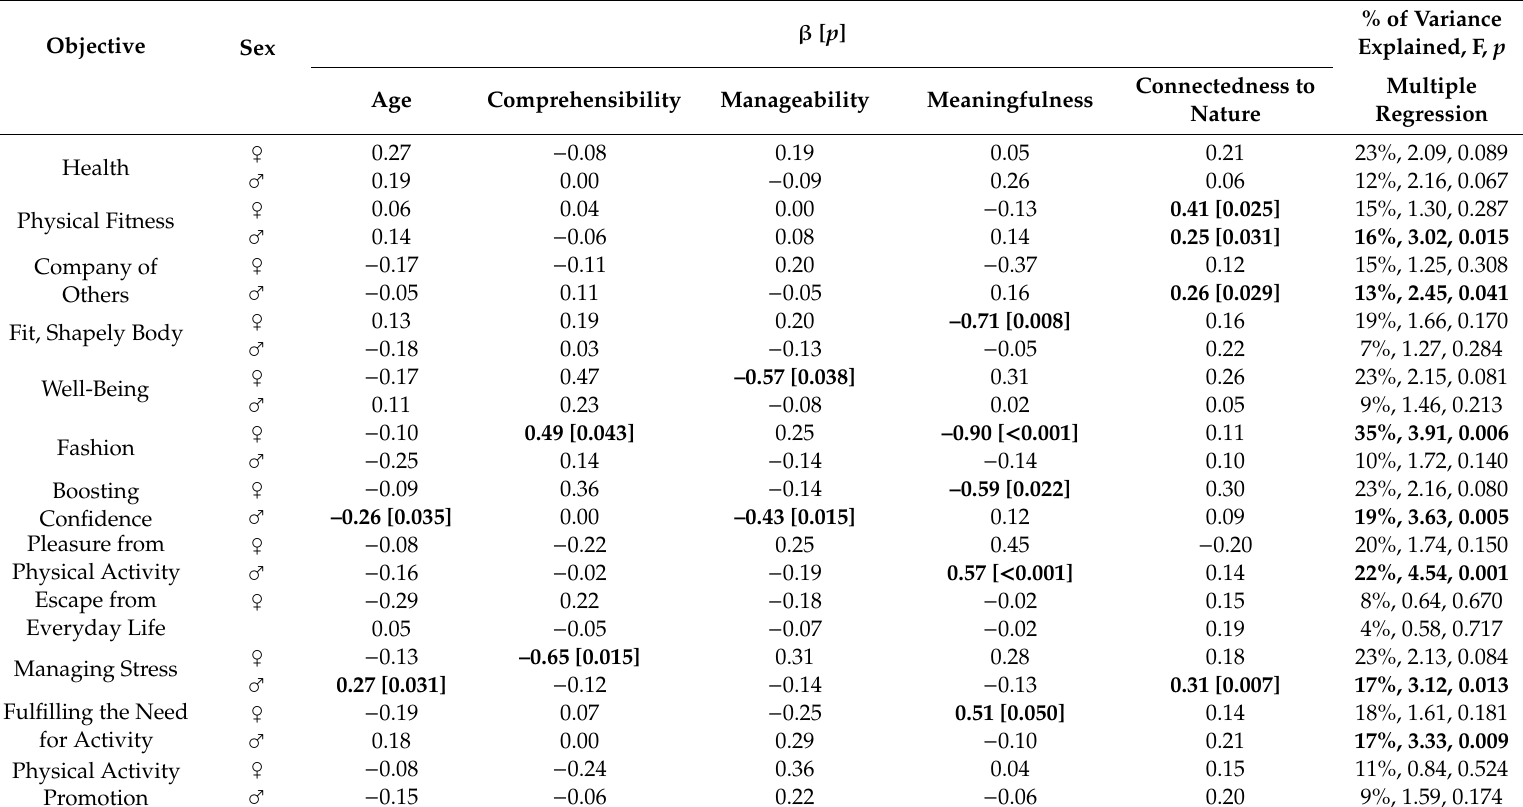
Table 3. Multiple regression on the motivations for physical activity (response variability) and age, sense of coherence dimensions, and connectedness to nature (explanatory